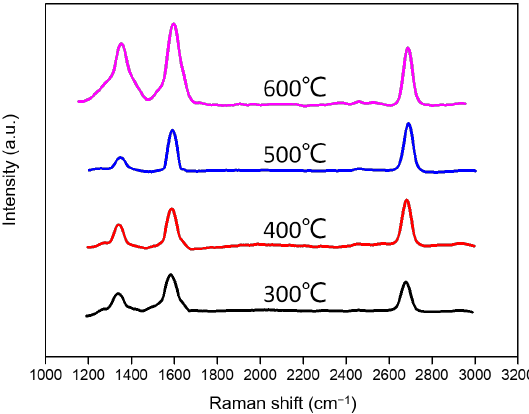
Figure 6. Raman spectrums of benzene-grown graphene at 300~600 °C.